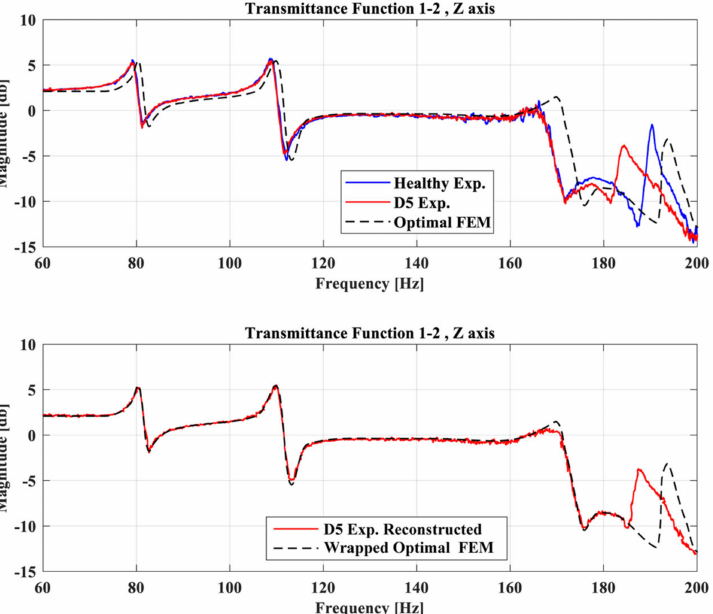
Figure 12. TFs of the Optimal FE model, healthy experimental and D5 case between accelerometer 1 and 2 at Z‑axis ( up ), and TFs of the Optimal FE model and the reconstructed damage curve ( down ).